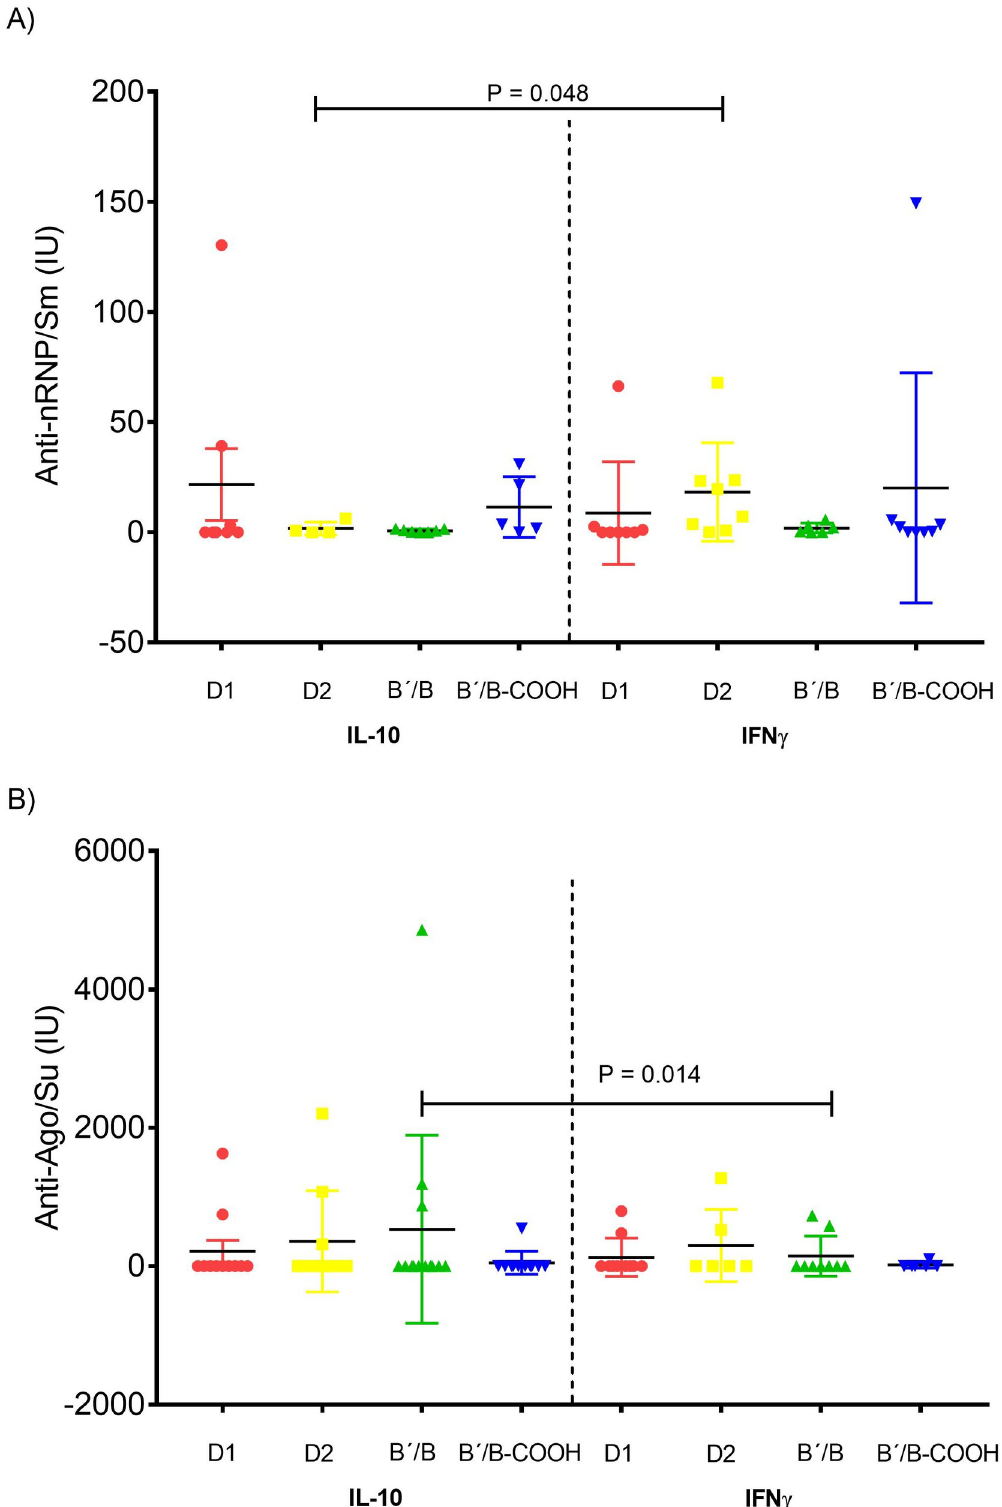
Fig 3. Effects of prophylactic co-vaccination of Sm antigens with IL-10 or IFN- γ on anti-nRNP/Sm and anti-Su/Ago2 antibodies level.